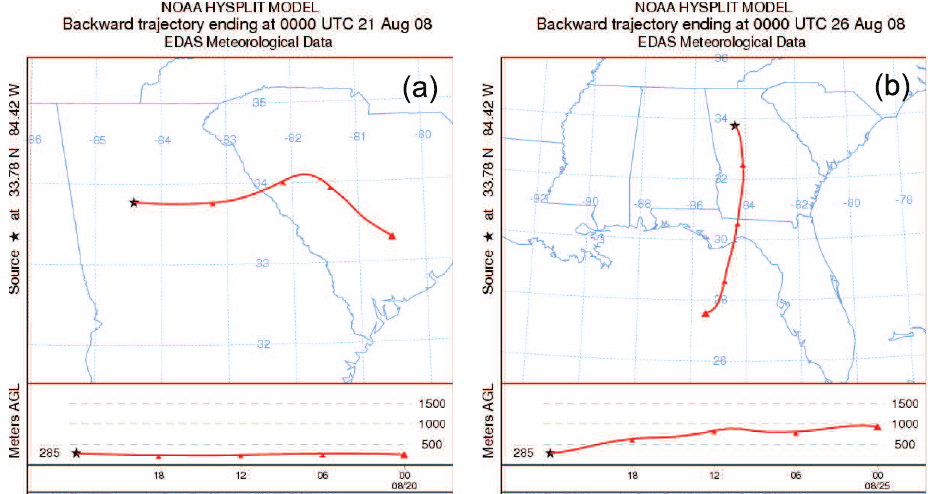
Fig. 1. HYSPLIT one day back-trajectories representative of the air masses sampled in JST during the AMIGAS campaign. (a) represents a “period A” air mass originating from the continental US; while (b) represents a “period B” air mass which originated from the Gulf of Mexico. During 24 August till the 27th, the air masses originated either from the Atlantic Ocean or the Gulf of